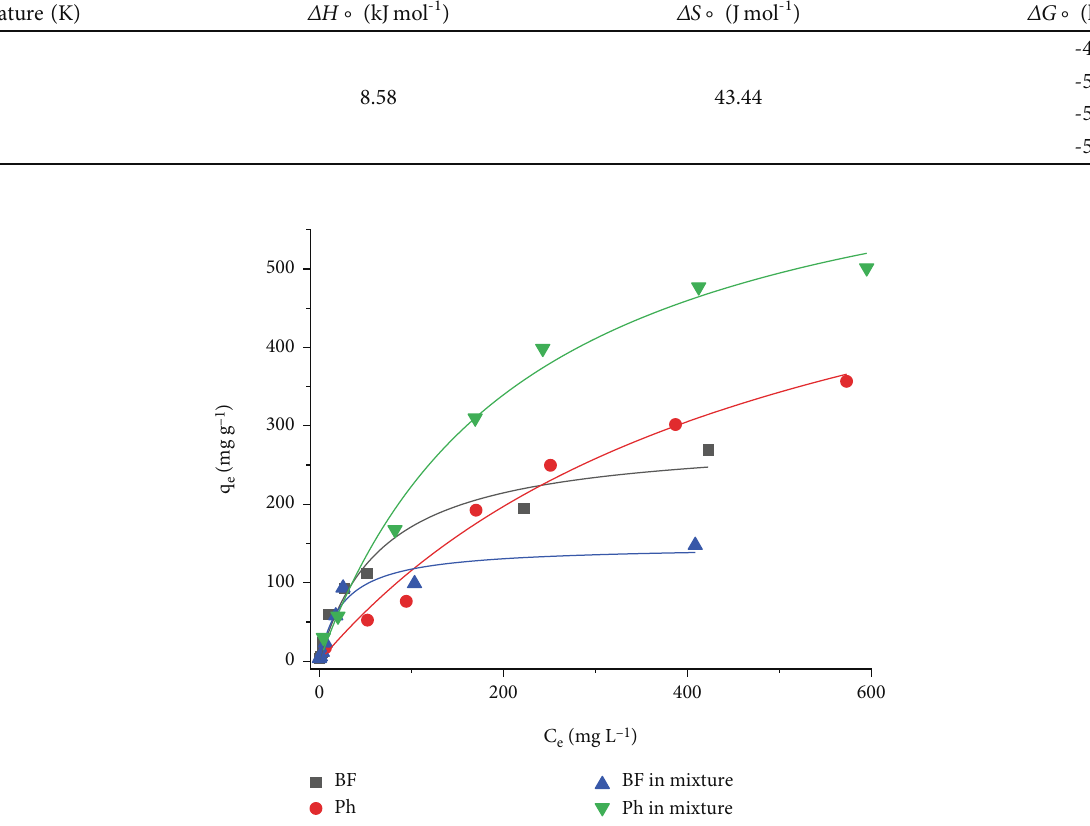
Figure 8: Adsorption isotherms of BF and Ph separately and in the mixture.